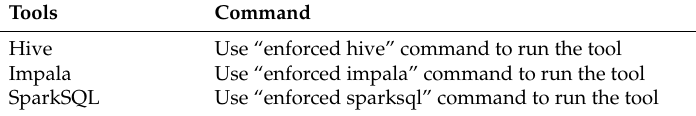
Table 3. Test tools.